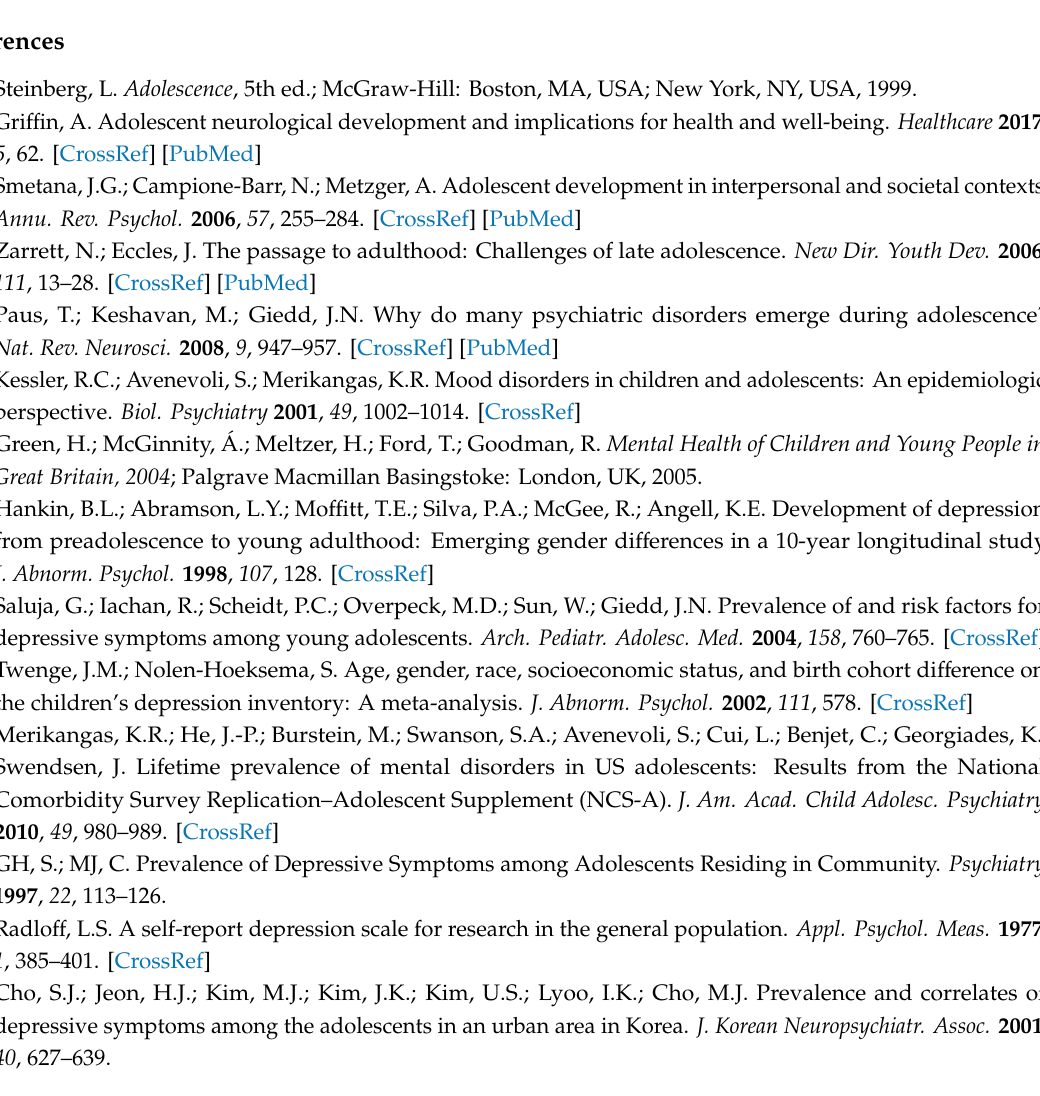
Table S1: The number of participants by academic years with the regional distribution; Table S2: General perceived subjective happiness of participants in each year; Table S3: Distribution of depressive episode, suicidal ideation, and suicidal attempt; Table S4: Mean scores of subjective happiness according to the demographic factors (mean; SD); Table S5: Logistic regression analysis for depressive episode, suicidal ideation, and suicidal attempt with the demographic variables; Table S6: Distribution of perceived economic status and school achievement in each year; Table S7: Social index of South Korea during the study